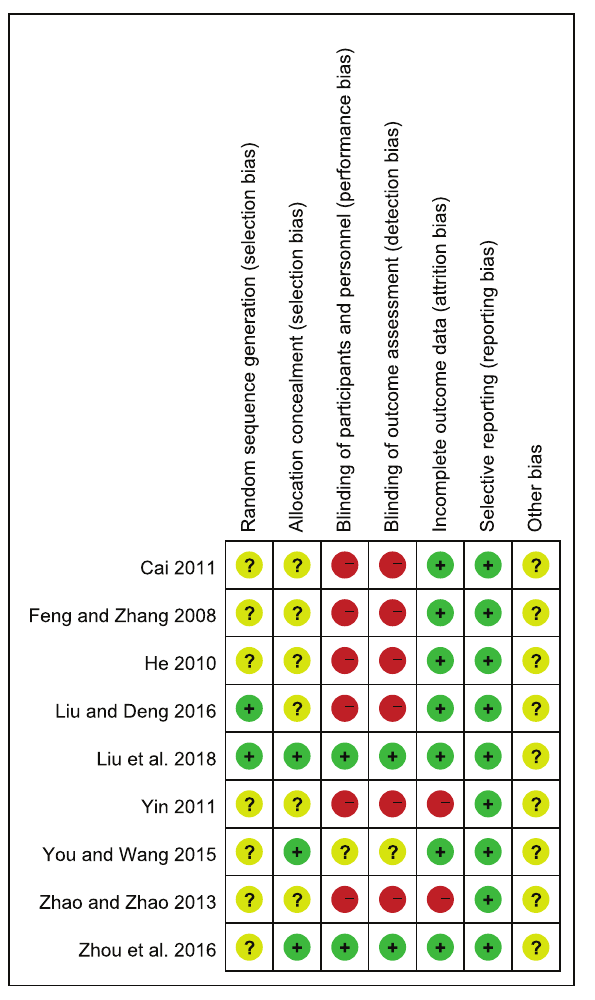
FIGURE 3 | Risk of bias summary of included